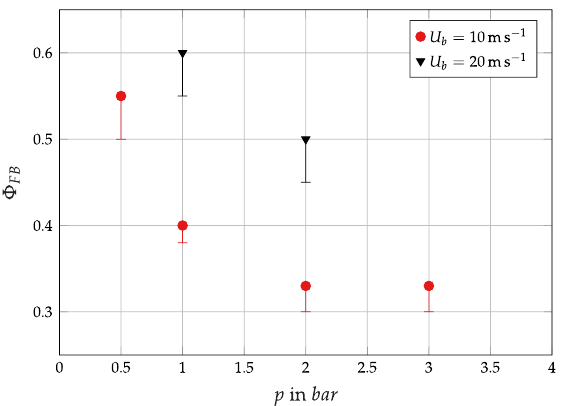
Figure 5. Pressure influence on numerical flashback